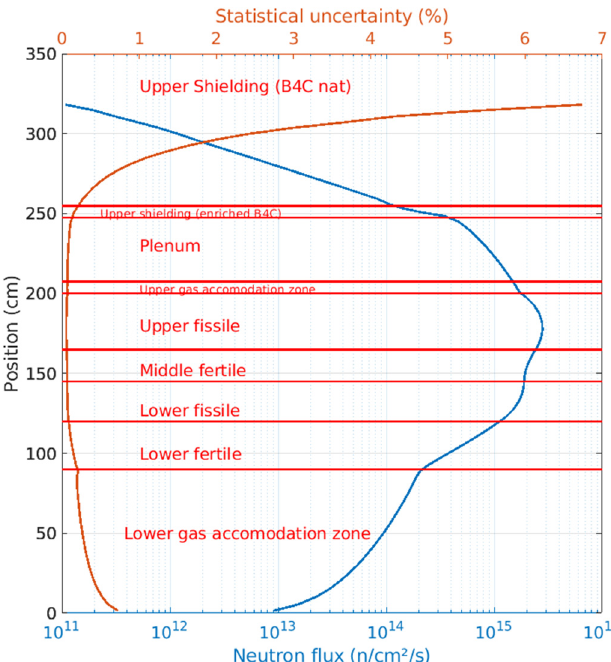
Fig. 5. Axial traverse of a fi ssile assembly obtained with a TRIPOLI-4 ® criticality